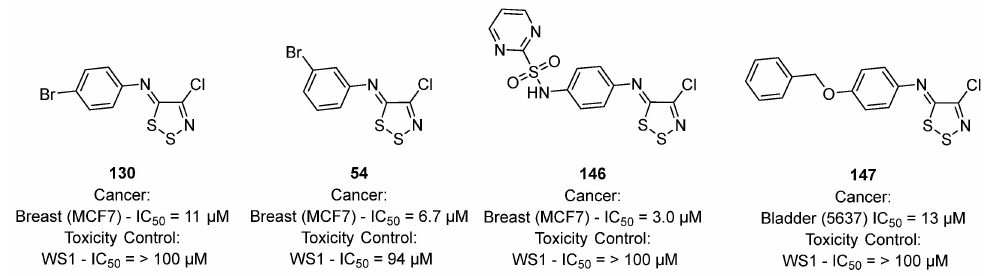
Figure 34. Initial screening highlighted results from the 2021 cancer panel by our group [74].